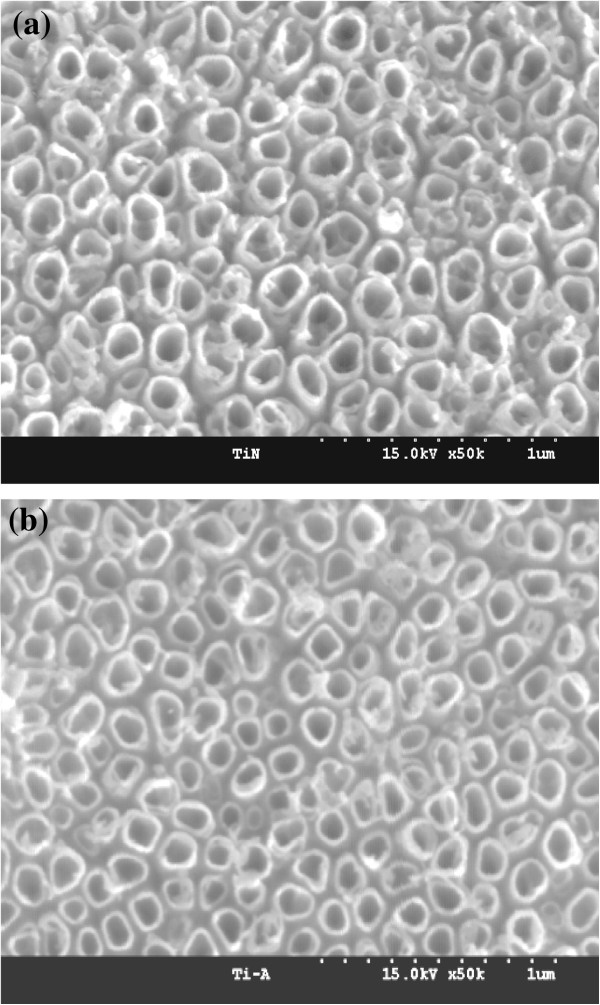
FE-SEM images of (a) nt-TiO2 and (b) nt-TiO2 -P.